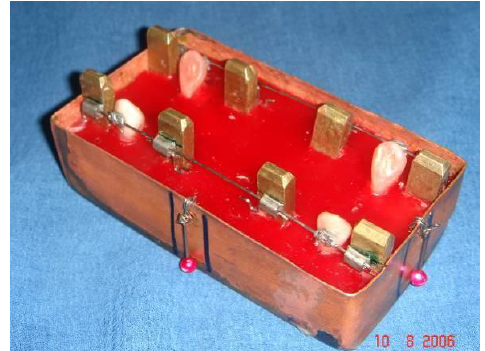
Figure 1: Test apparatus with different bracket ligations.